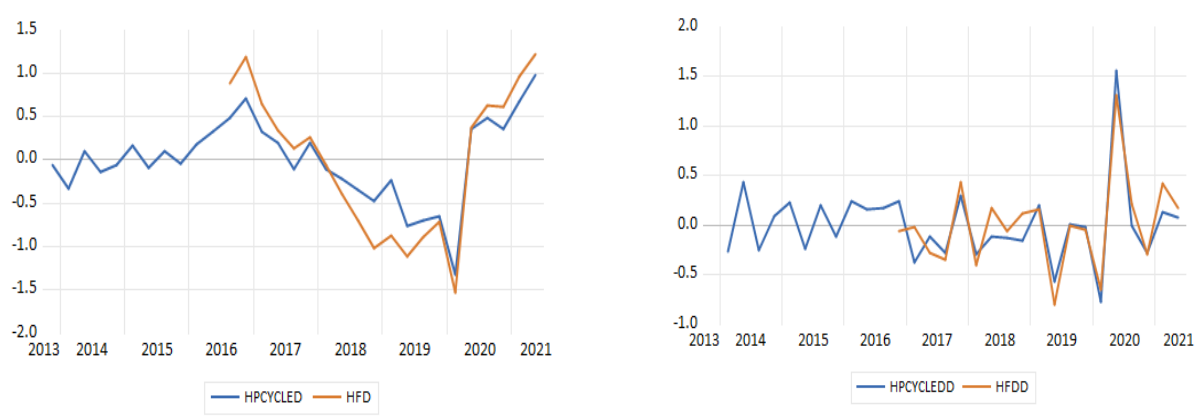
Figure 5. HP (1600) filter (blue) versus 2-year regression filter HF (brown), fourth period.